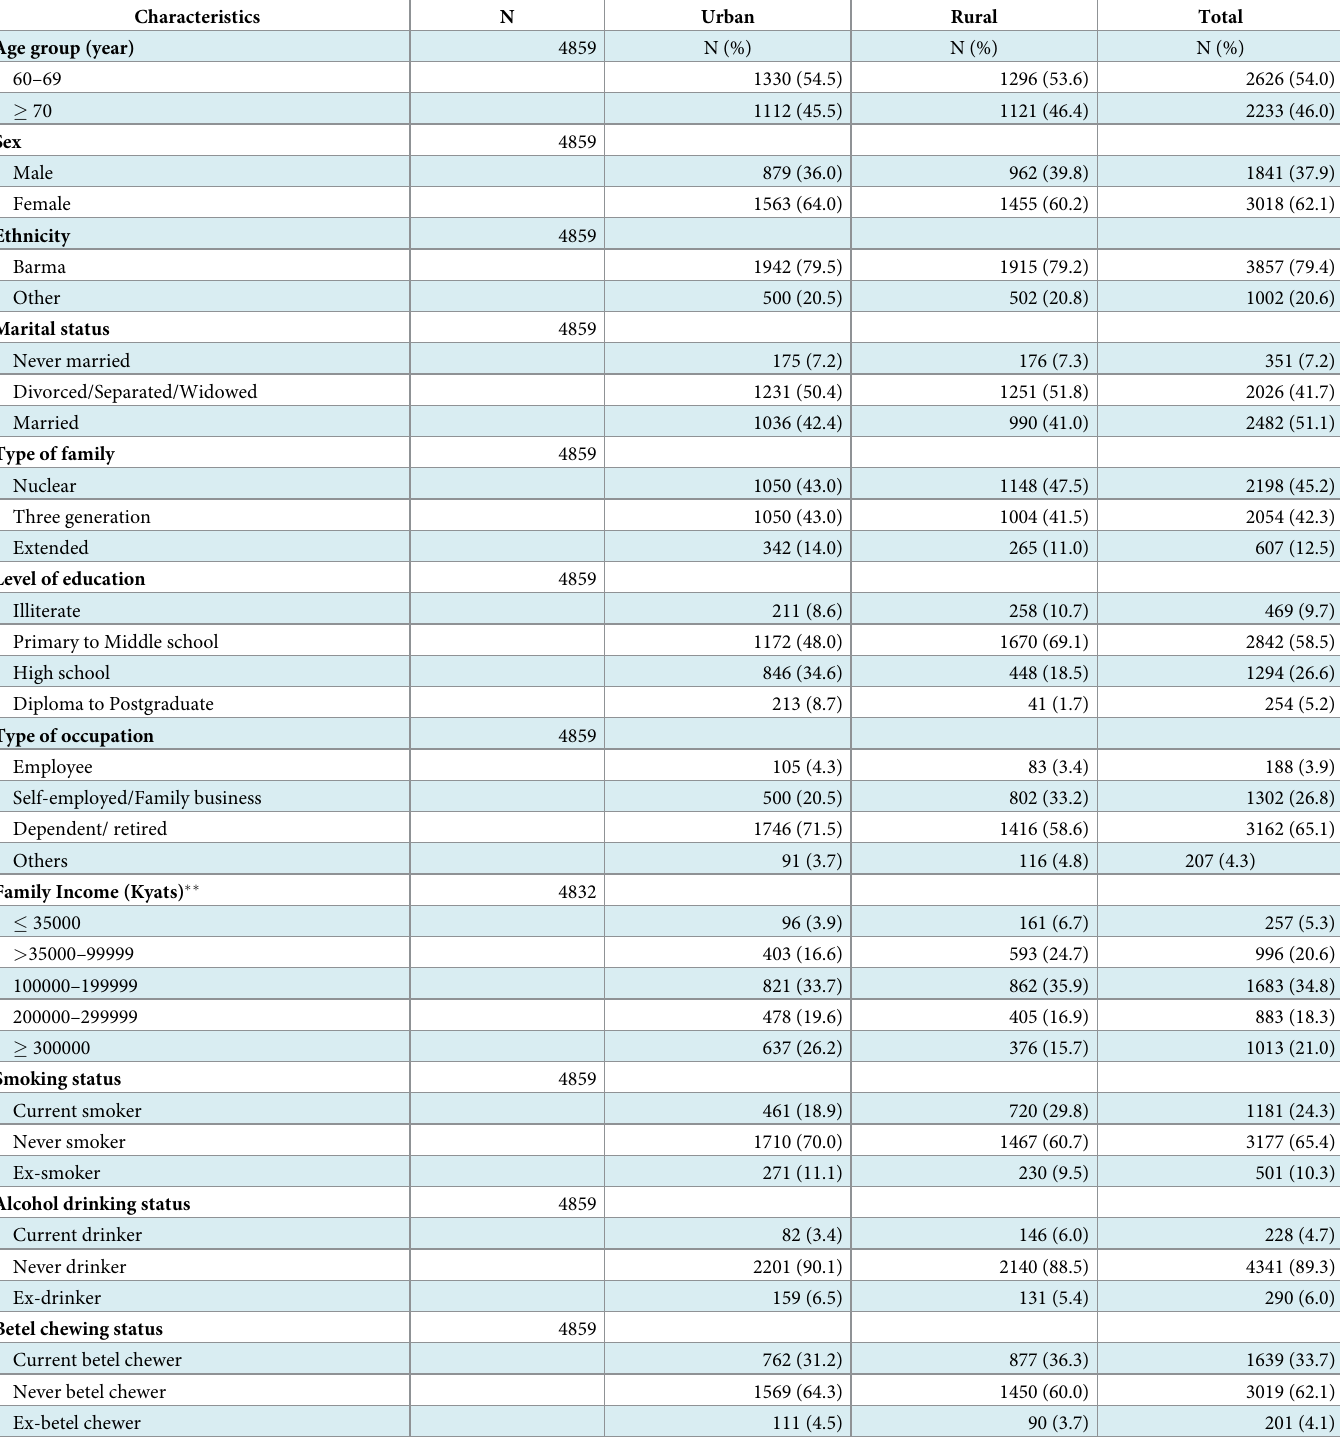
Table 1. Socio-demographic and personal characteristics of study